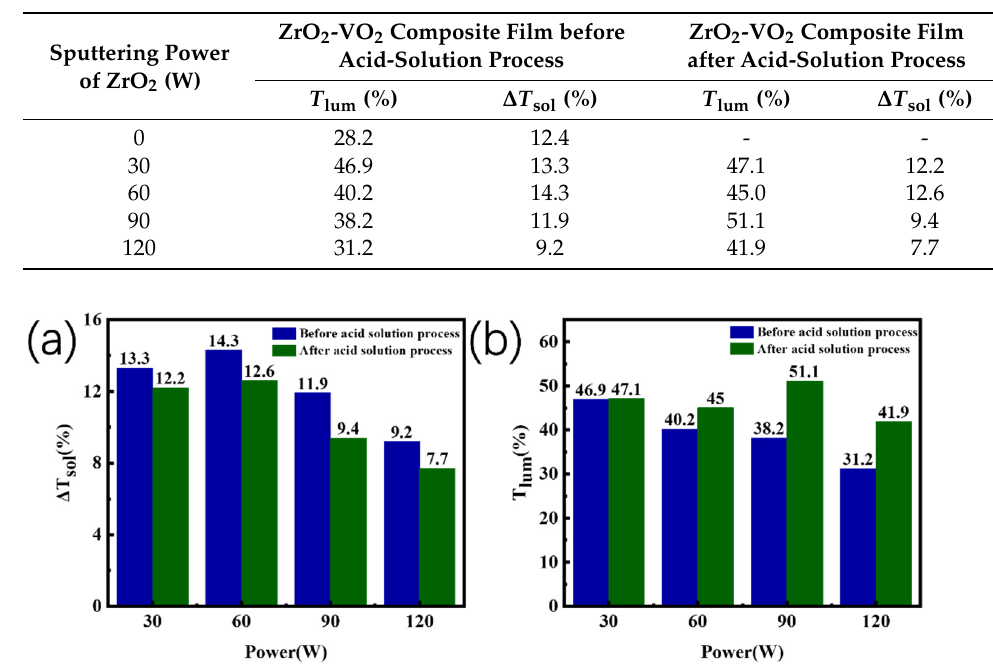
Figure 4. The transmittance of ( a ) samples ZrO 2 -30 W, ZrO 2 -60 W, ZrO 2 -90 W, and ZrO 2 -120 W, and ( b ) samples ZrO 2 -30 W-acid, ZrO 2 -60 W-acid, ZrO 2 -90 W-acid, and ZrO 2 -120 W-acid at 20 °C (line) and 90 °C (short point line), respectively.